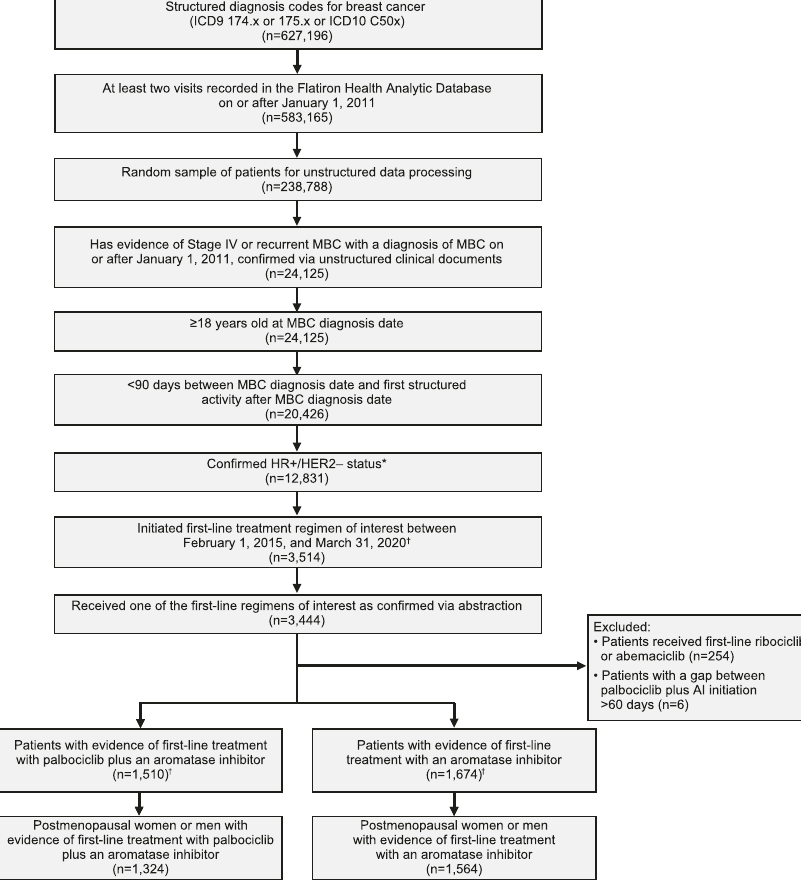
Fig. 1 Patient attrition diagram. ER + estrogen receptor – positive; HER2 − human epidermal growth factor receptor 2 – negative; HR + hormone receptor – positive; ICD9/10 International Classi fi cation of Diseases, 9th/10th Revision ; MBC metastatic breast cancer; PR + progesterone receptor – positive. *Con fi rmed HR + /HER2 − status: HR + is de fi ned as any ER + or PR + biomarker test before or up to 60 days after metastatic diagnosis; HER2 − is de fi ned as any HER2 − test and the absence of a positive test before or up to 60 days after metastatic diagnosis. † Lines were selected regardless of whether they contained a luteinizing hormone – releasing hormone agonist (leuprolide, goserelin, and